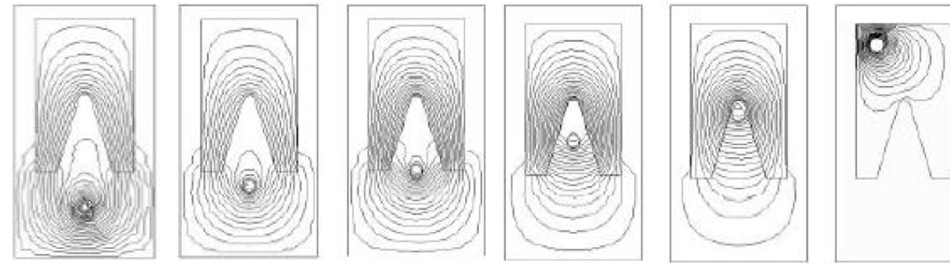
Figure 4. Magnetic field distribution for different positions of the arc in the Deion plate [2].